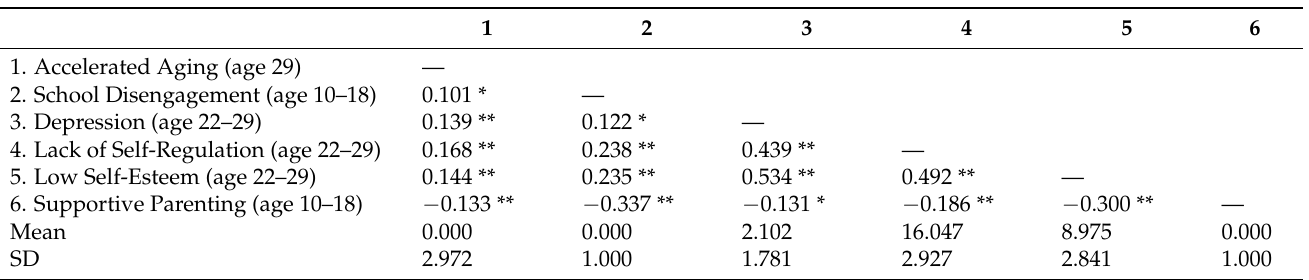
Table 2. Correlation among School Disengagement, Depression, Poor Self-regulatory, Low Self Esteem, Supportive Parenting, and Accelerated Aging ( n =